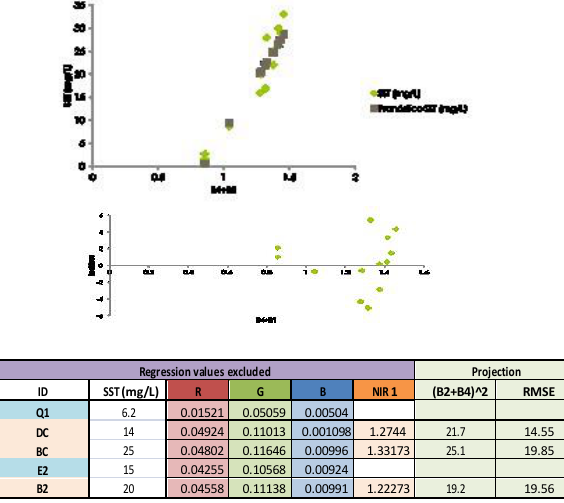
Figure 3 RMSE for excluded values, linear regression fit between in situ TSS and reflectance values and residual